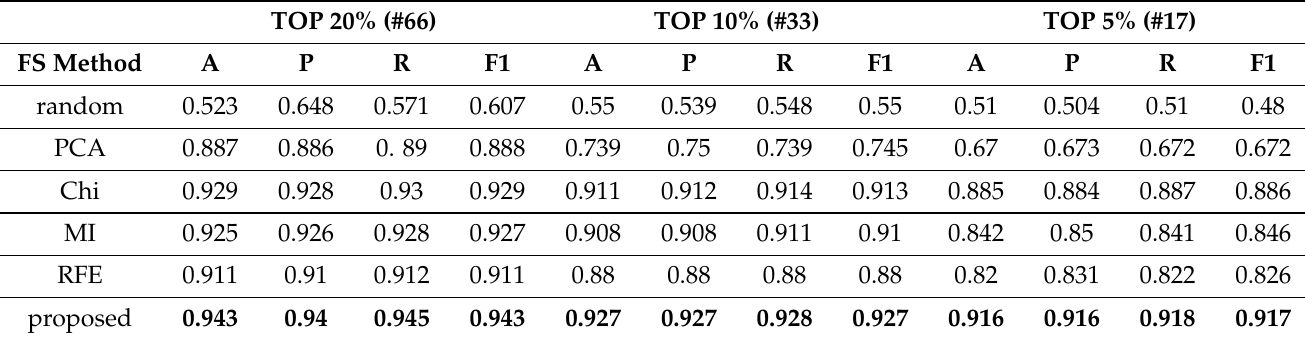
Figure 11. The selected features in 4 different sessions with the same hyperparameter settings: f = 0.2, final _ prec = 0.75, des _ feat _ num = 10%. Each color corresponds to a session, thus, features that are represented with more than one color, were selected into the final subset multiple times. This implies that these features have the highest predictive power. Table 7. Classification performances when training with the subsets of the TOP 20%, 10%, and 5% of the original features generated using different FS methods. The indicated metrics—Accuracy (A), Precision (P), Recall (R) and F1-score (F1)—are calculated using macro